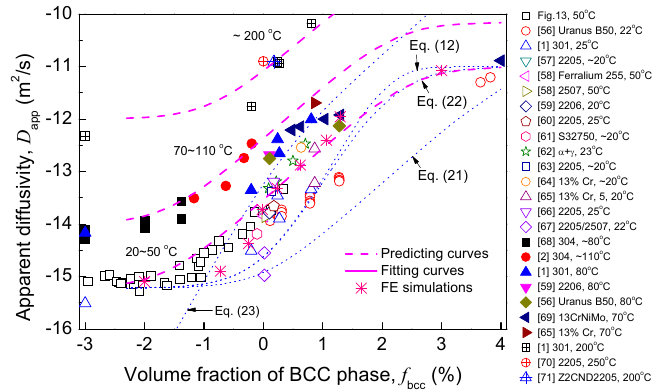
Figure 13. Relation between log(cid:1830) (cid:2911)(cid:2926)(cid:2926) and log(cid:4670)(cid:1858) (cid:2961)(cid:4593) (cid:4666)1 (cid:3398) (cid:1858) (cid:2961)(cid:4593) (cid:4667)⁄ (cid:4671) . (*: These data were obtained for a 304 steel in another ongoing study. The steel was firstly prestrained and then submitted to sensitization for different times to vary the content of pre ‐ existing α′ ).